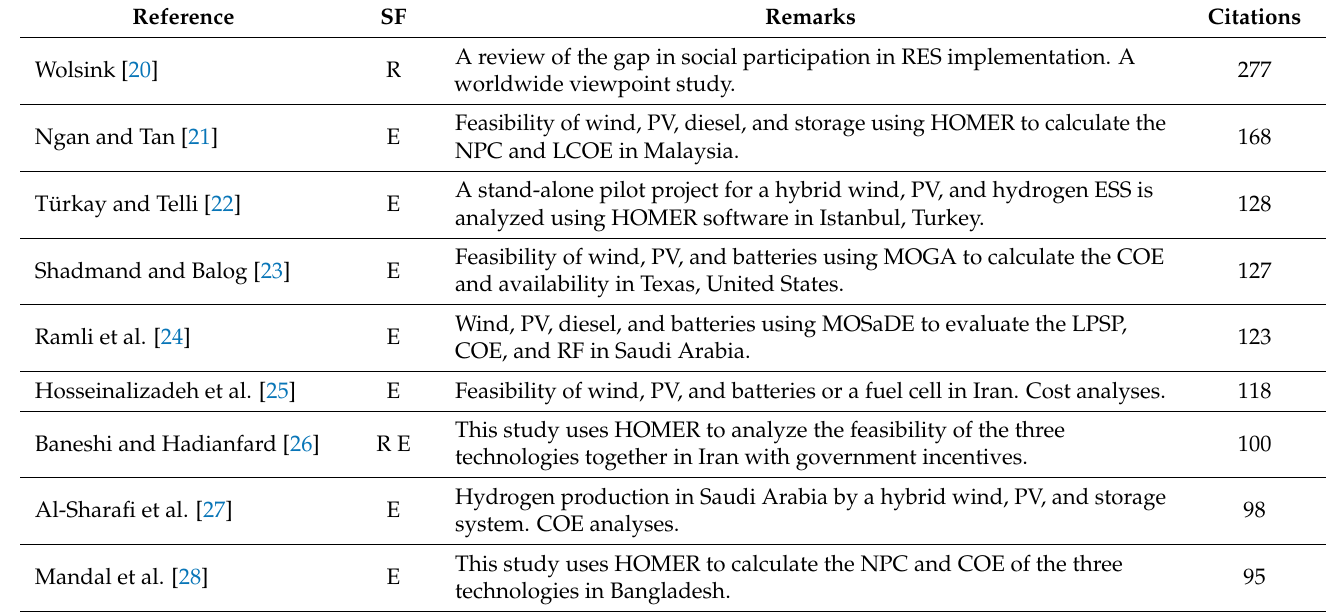
Table 2. The most-cited articles with more than 15 citations (SF, Search Field; R, Regulatory; E,